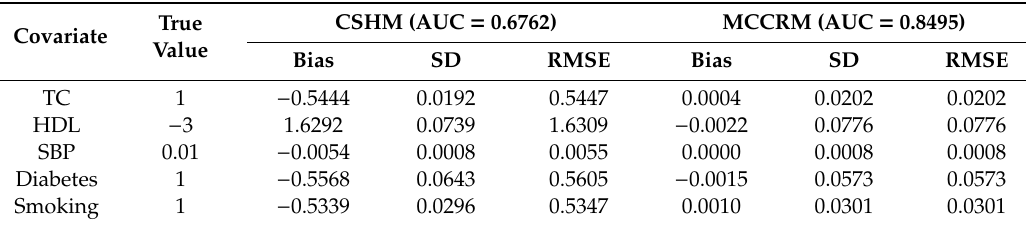
Table 3. Comparisons of coe ffi cients of the two models.